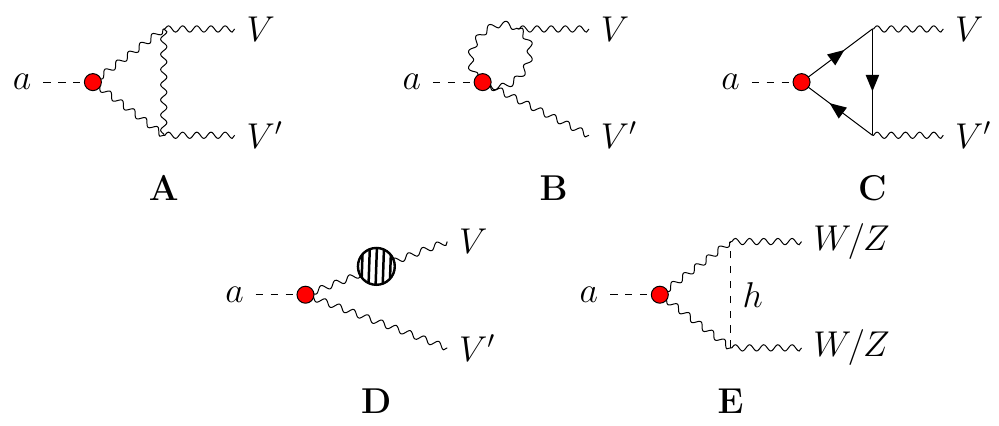
Figure 4 . One-loop diagrams contributing to g agg , g aγγ , g aγZ , g aZZ and g aWW at one-loop (the corresponding diagrams with Goldstone bosons and the diagrams exchanging the gauge boson legs are left implicit), where V and V 0 are either a gluon, a photon, a Z boson or a W boson. The last diagram only corrects insertions of the g and g aZZ aWW